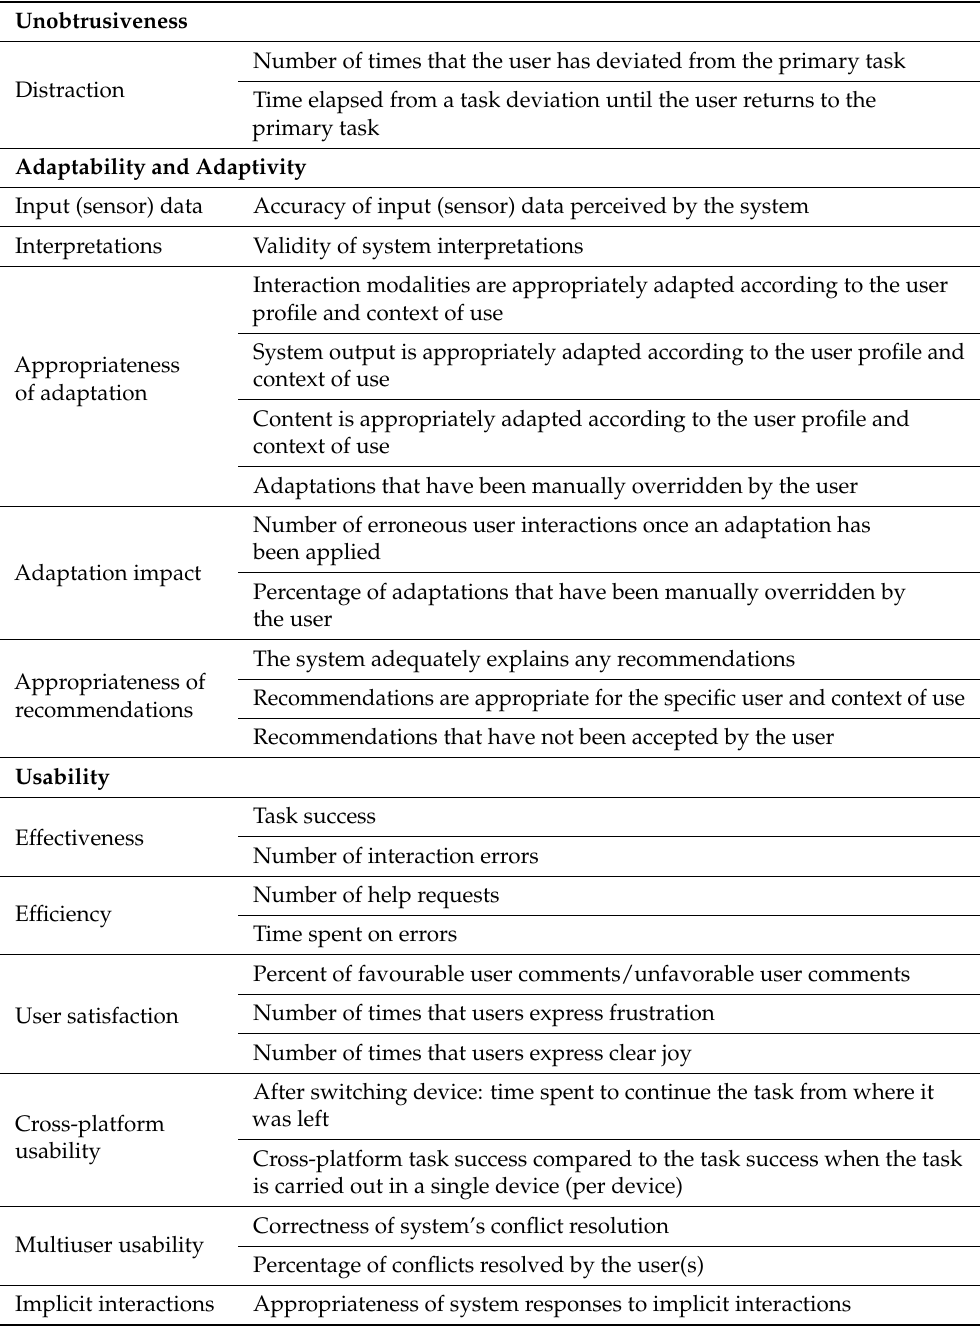
Table A4. UXIE metrics that should be measured during a user-based study and can have automation support by